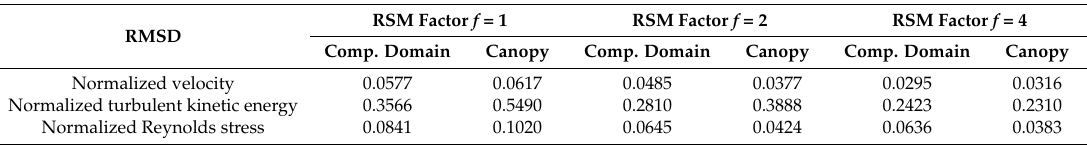
Table 5. Root mean square deviation (RMSD) between large-eddy simulation (LES) and Reynolds stress model (RSM) using different internal time scale factors f .